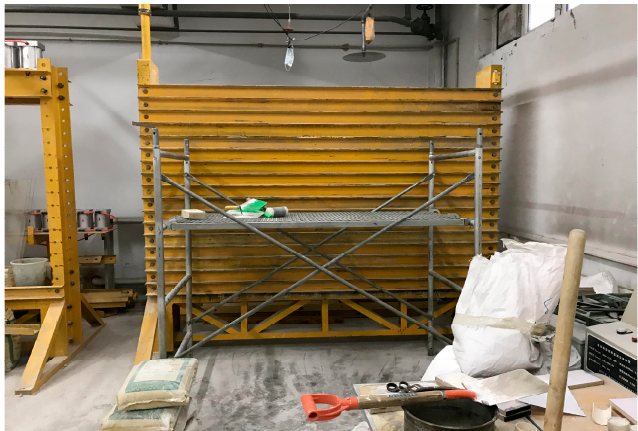
Figure 5. Test platform developed by the Mine Pressure and Stratum Control Laboratory.